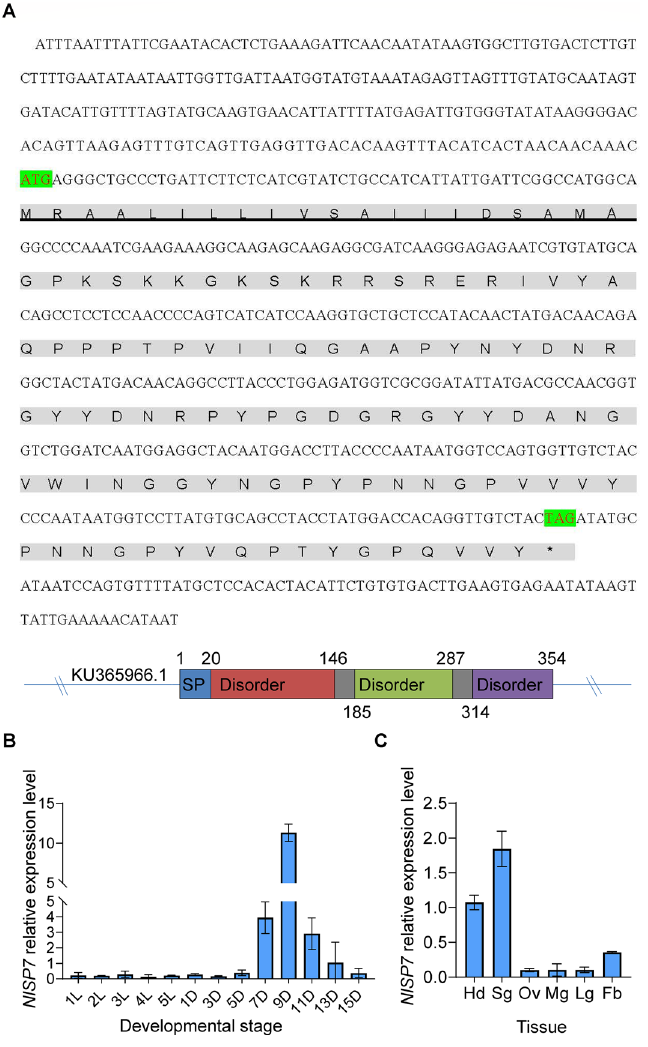
Figure 1. Characterization of NlSP7 . ( A ) CDS sequence of NlSP7 . The solid underline indicates the signal peptide as predicted by SignalP 5.0. The asterisk (*) indicates the stop codon. The different short-repeat regions are indicated by different colors. ( B , C ) The bottom panels show the mean transcript levels ± SD (n = 30) of NlSP7 in whole bodies at various developmental stages ( B ) and in different tissues ( C ). RNA was extracted from nymphs at 1–5 days and female brachypterous brown planthoppers reared on Rathu Heenati rice at 1, 3, 5, 7, 9, 11, 13, and 15 days. Hd, head; Sg, salivary gland; Ov, ovary; Mg, midgut; Lg, leg; Fb, fat body was extracted from BPH